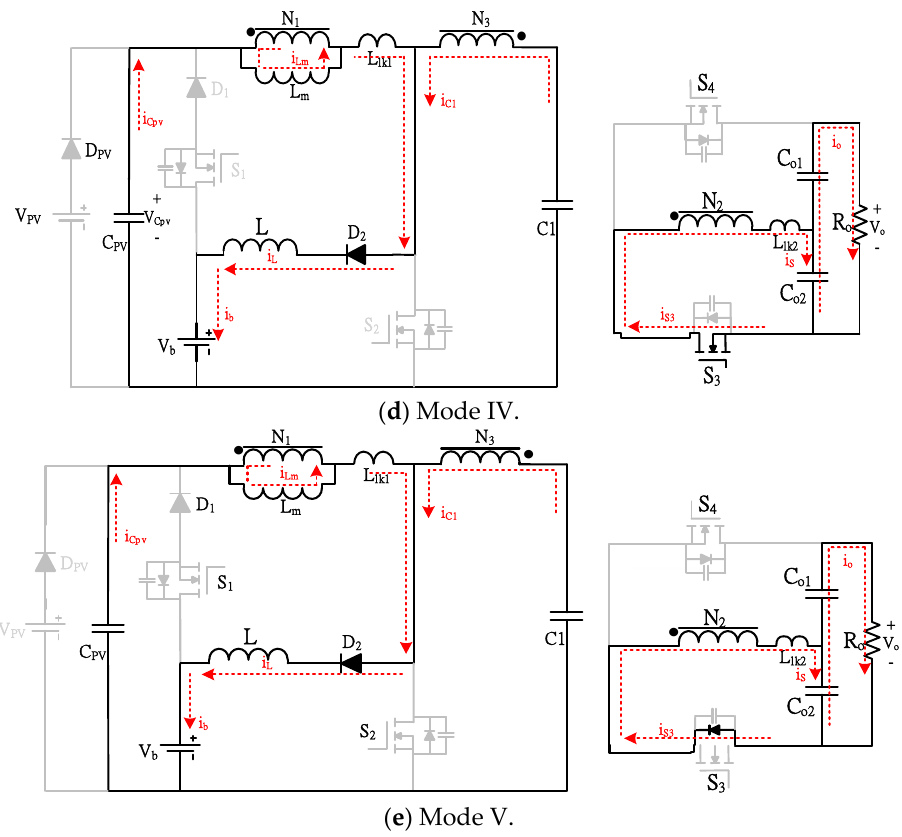
Figure 6. Operational diagram of each mode in Stage 2: ( a ) Mode I, ( b ) Mode II, ( c ) Mode III, ( d ) Mode IV, and ( e ) Mode V.